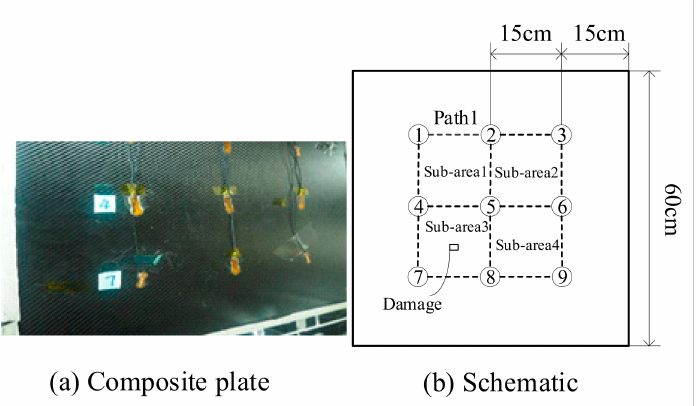
Figure 13. Experimental piece and its schematic.